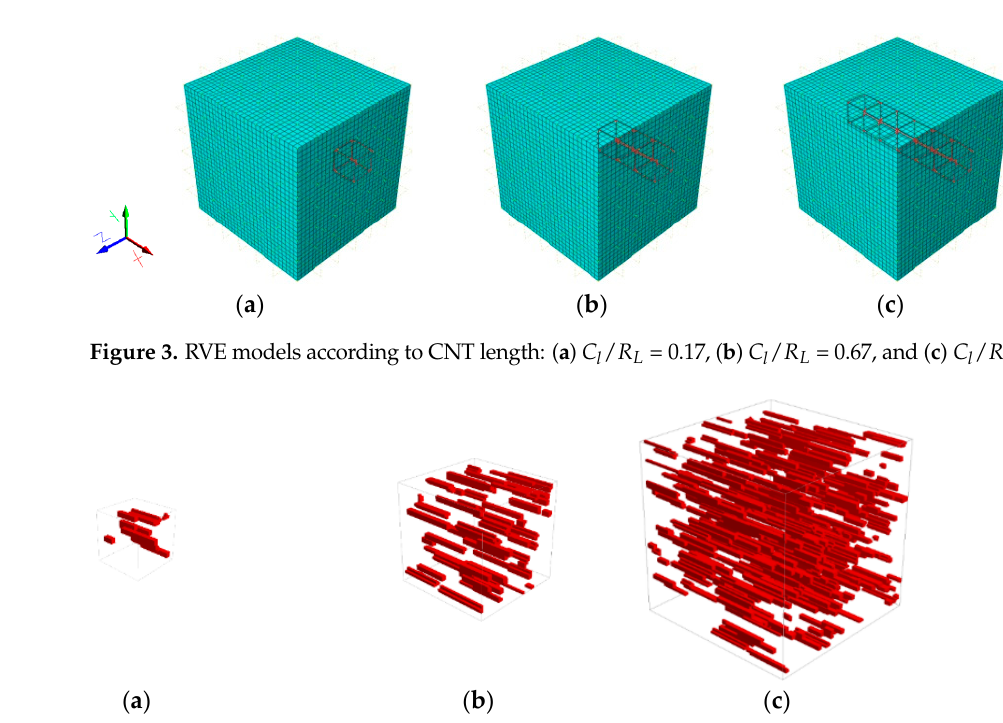
Figure 4. Models according to changes in the RVE length: RVE = ( a ) 2, ( b ) 4, and ( c ) 8 µm.